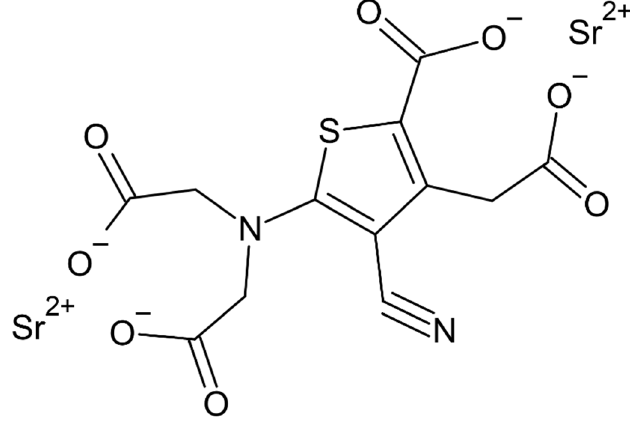
Figure 2. Strontium ranelate.